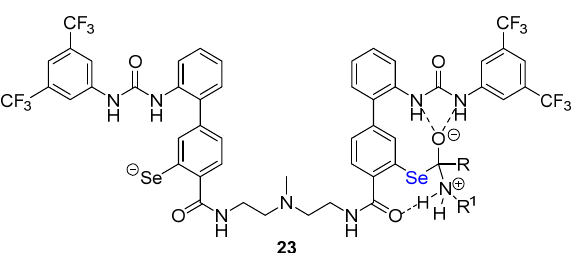
Figure 5. Urea ‐ stabilized tetrahedral intermediate using organocatalyst 23. Figure 5. Urea-stabilized tetrahedral intermediate using organocatalyst 23